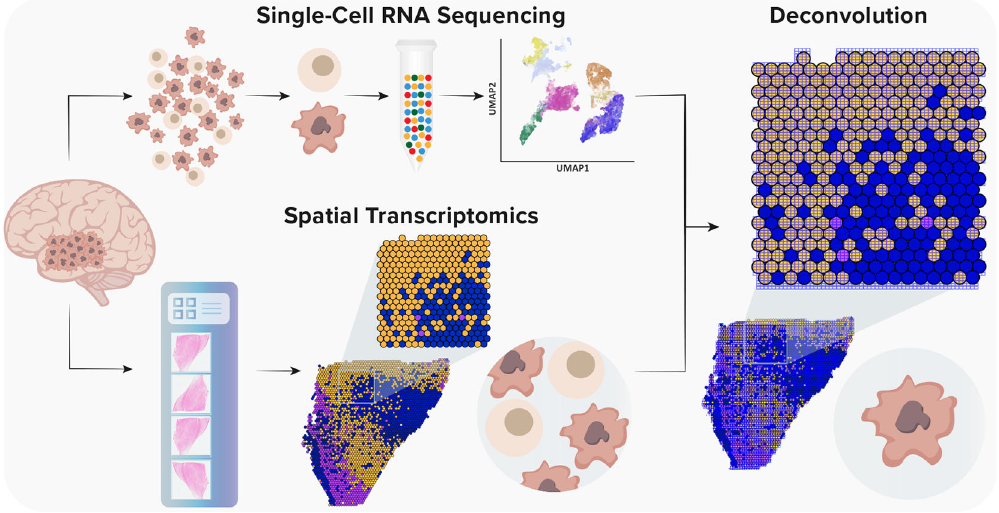
Figure2.Integration(deconvolution)strategyofsingle-cellRNAsequencingandspatialtranscriptomicsdata (based on the 10x Genomics protocol). Single-cell RNA sequencing provides high-throughput and